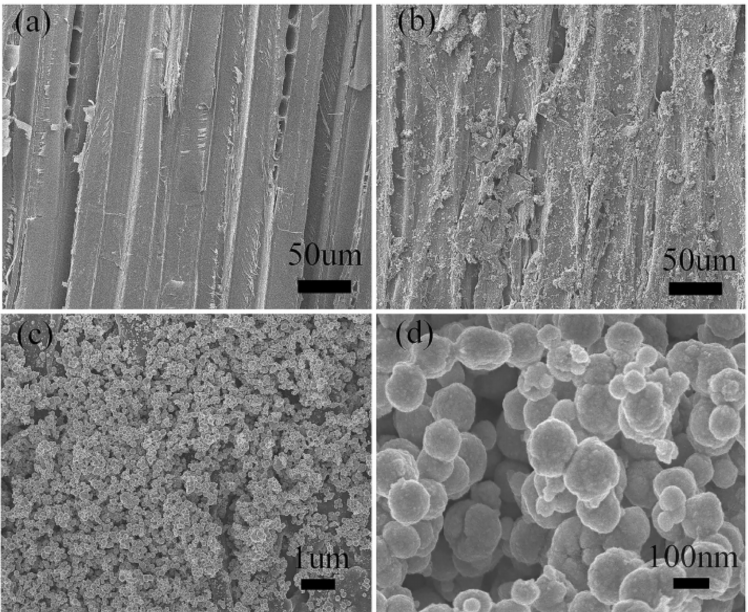
Figure 4. Scanning electron microscopy (SEM) images of unmodified wood and MW–18 wt %. ( a ) Unmodified wood (2000 × ), ( b ) modified wood (2000 × ), ( c ) FeNi 3 nanoparticles (100,000 × ), ( d ) FeNi 3 nanoparticles (1,000,000 × ).